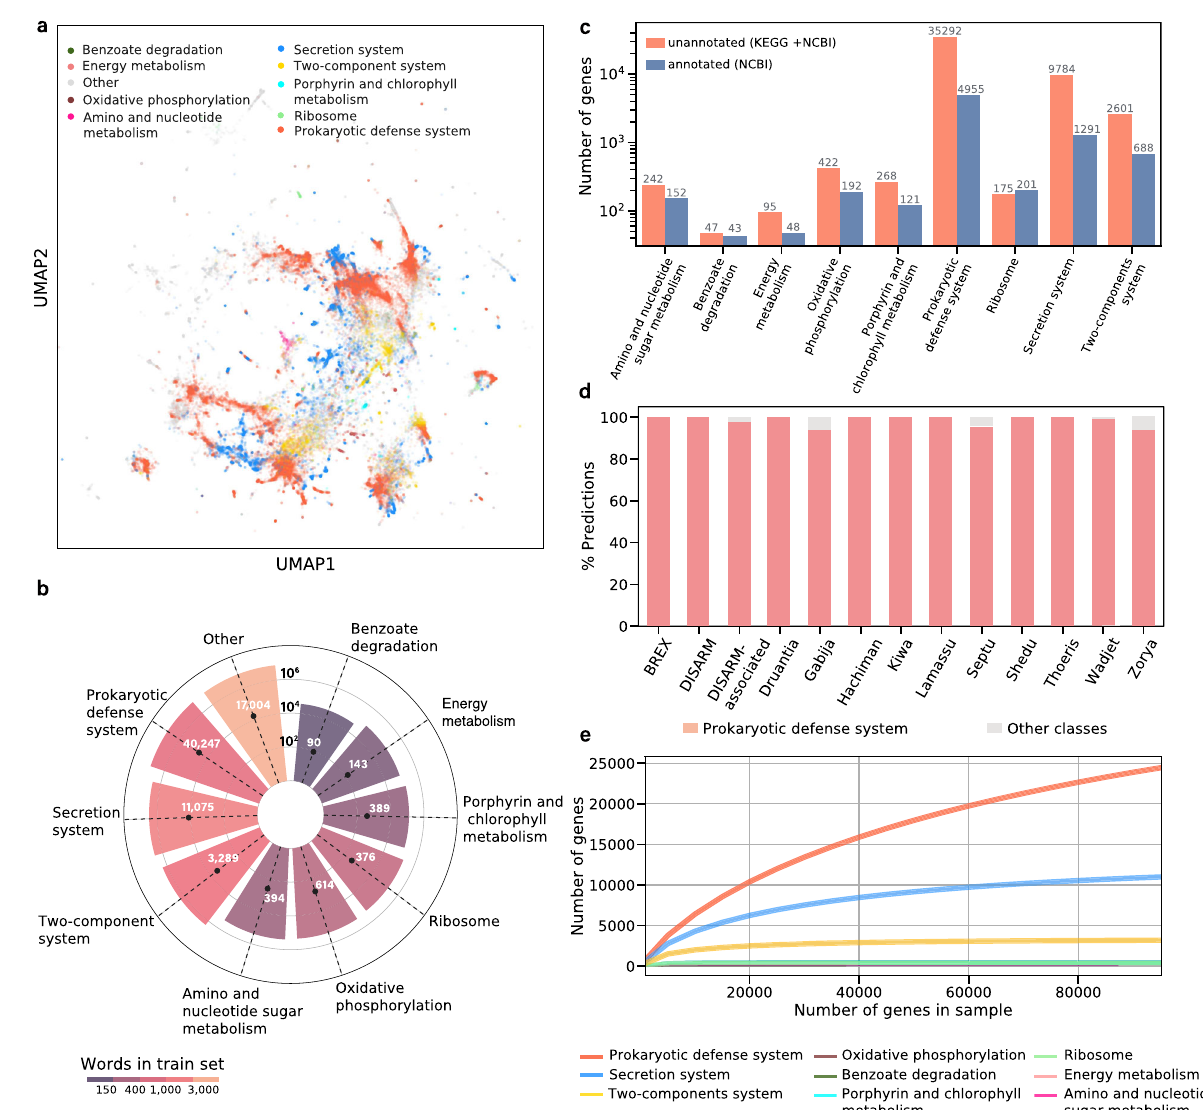
Fig. 4 | Functional prediction of hypothetical gene families. a The complete prediction space. The gene families are color-coded based on the predicted func- tional categories. b Predictions per functional category. Each bar represents the total number of hypothetical genes assigned to a category. The black dot repre- sents the number of hypothetical gene families that received the category pre- diction.The number of predicted families is explicitlystatednextto eachdot.Bars are color-coded by the number of words per functional category used to train the